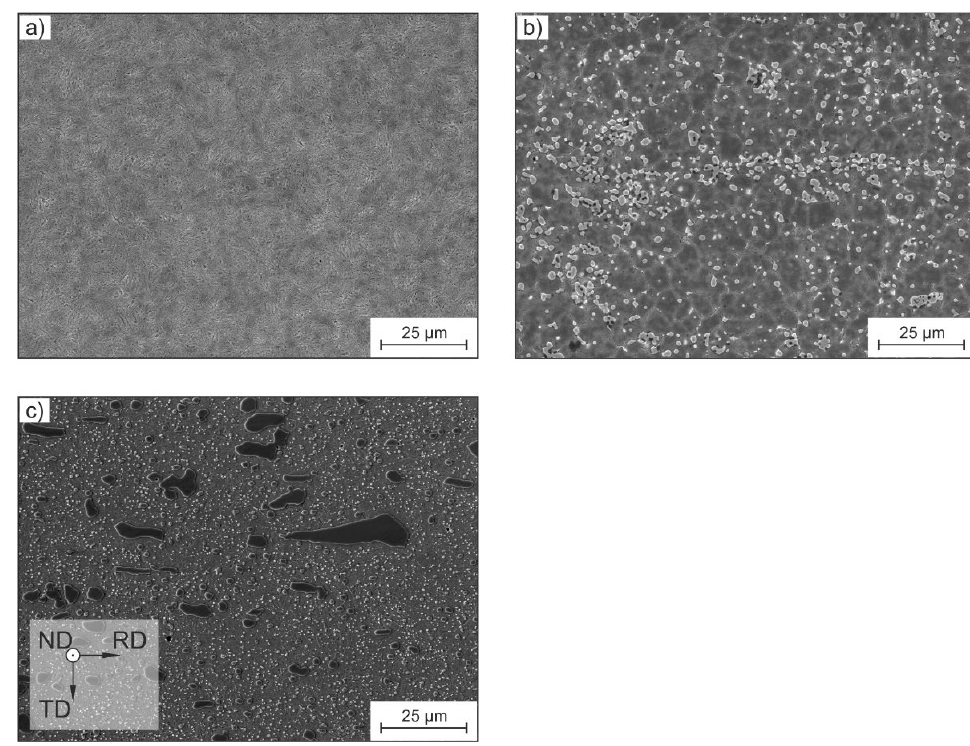
Figure 2. SEM images of ( a ) tool steel L2, ( b ) high-speed steel M2 and ( c ) ledeburitic cold-work steel D2 in the orientation given in the provided axes.